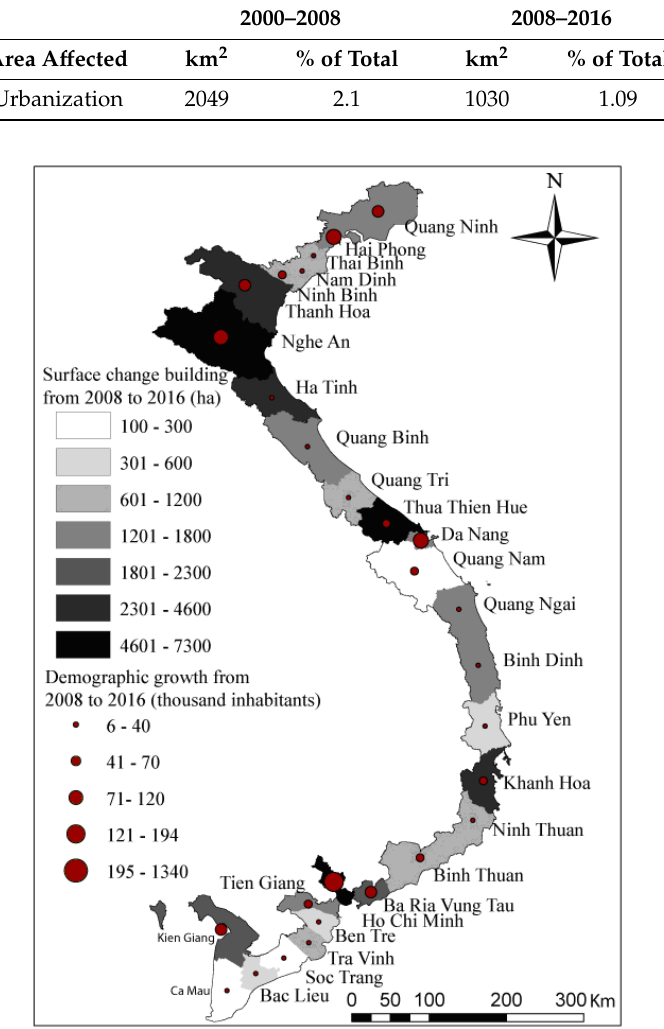
Figure 11. Changes of the built-up surface and increase of population during 2008–2016 in Vietnam.